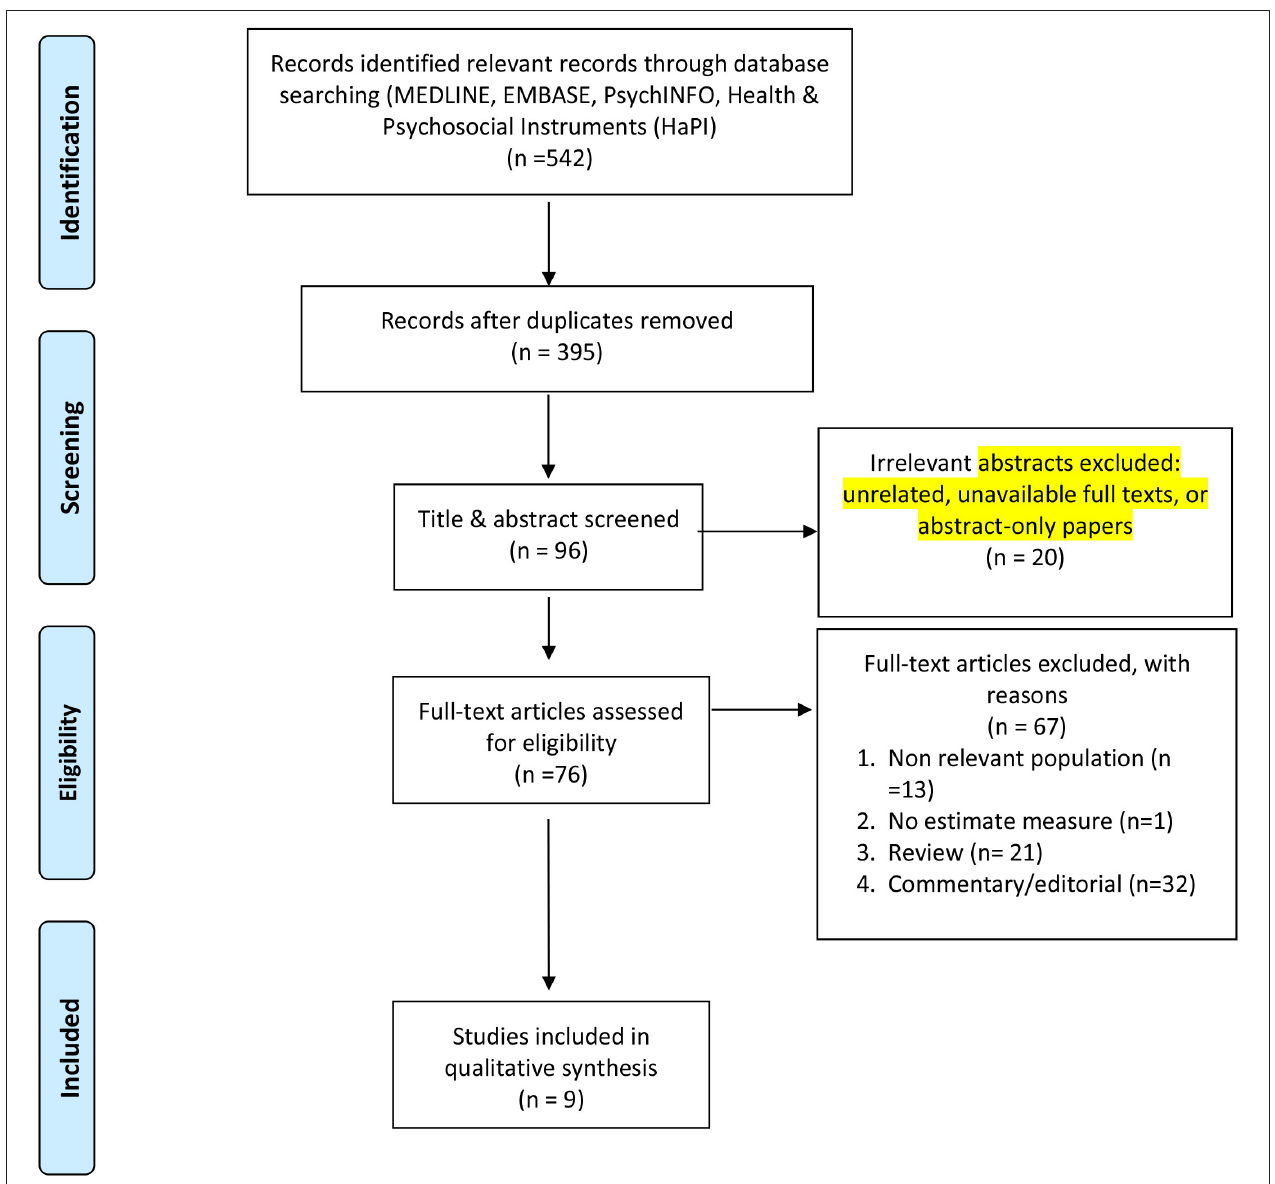
FIGURE 1 | PRISMA flow diagram: original studies reporting on the impact of the coronavirus pandemic on professional